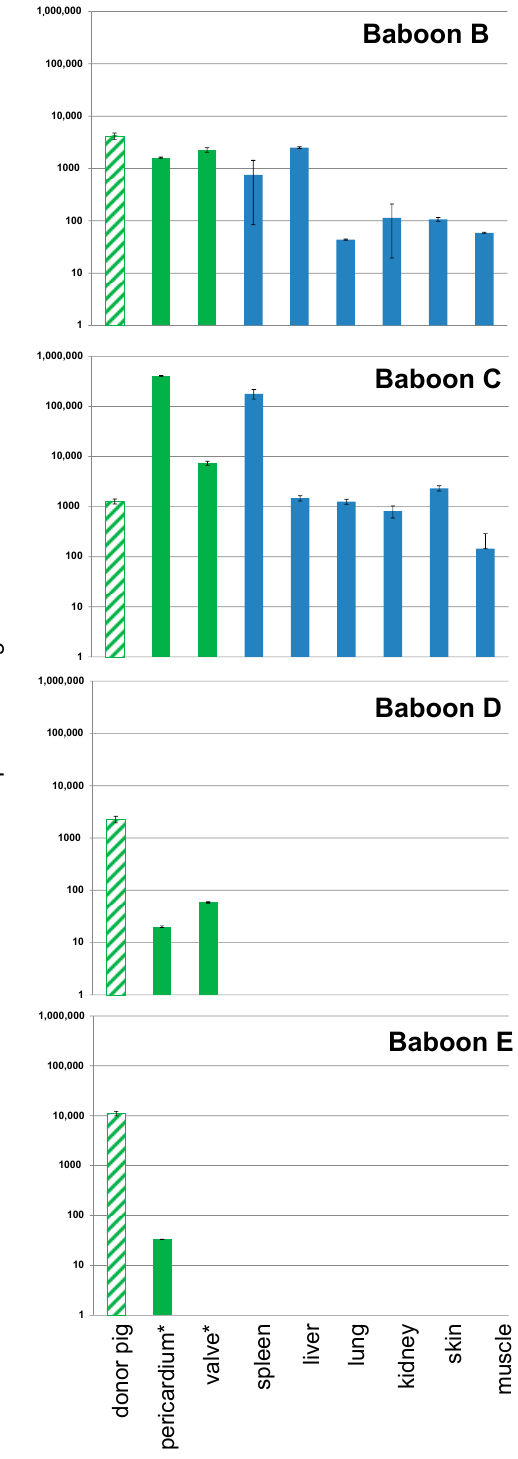
Figure 1. Detection of PCV3 in the organs of four PCV3-positive donor pigs (green hatched), in the transplanted pig heart after its removal at the end of the study (green) and in di ff erent organs of the baboon recipient (blue). Column “donor pig”: In the case of baboons B and C the spleens of the donor pigs were analyzed, in the case of baboon D and E the lungs of the donor pigs. Since in the case of baboon D no pericardium and valve material was available, myocardial tissue from the right and left ventricle was tested instead (*). The standard deviation is from two independent